Question: In a single sentence, describe what this figure presents.
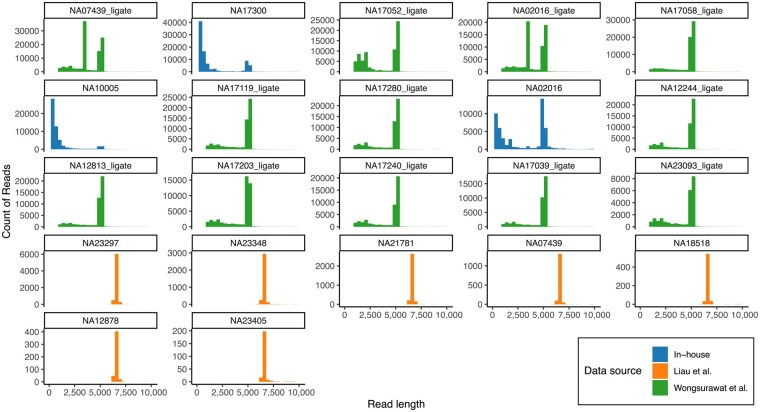
Answer: Distribution of read lengths for all samples. Samples ordered by decreasing numbers of total reads. In all cases, a population of reads at the expected 5.1–6.6 kb range is seen. In-house generated samples (blue) show higher than expected numbers of short reads, suggestive of degraded DNA amplicons during library preparation. The x-axis was truncated at 10 000 bp, removing an average of 0.37 % of reads per sample from display.